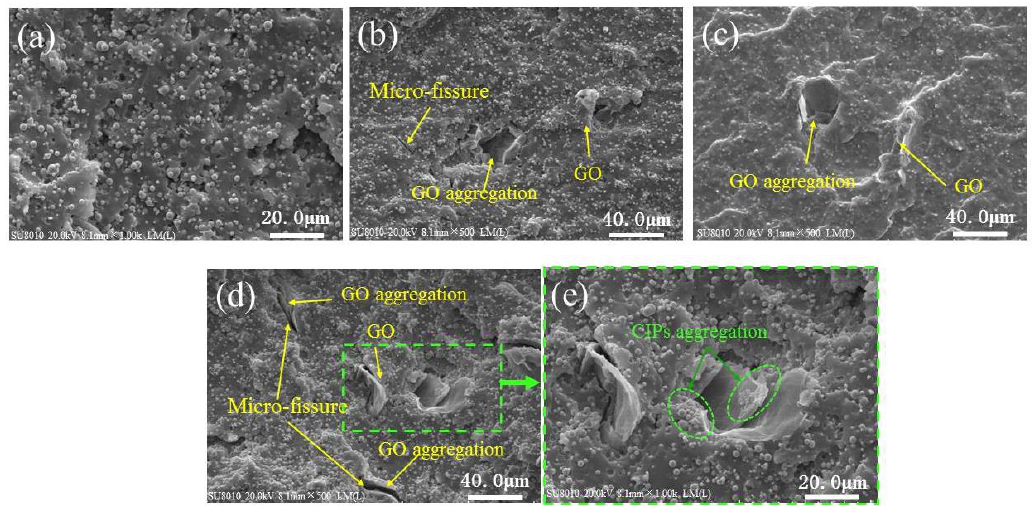
Figure 3. SEM images of: ( a ) MRE-0; ( b ) MRE-1; ( c ) MRE-3; ( d ) MRE-5; and ( e ) a locally magnified view of the fractured surface of MRE-5.